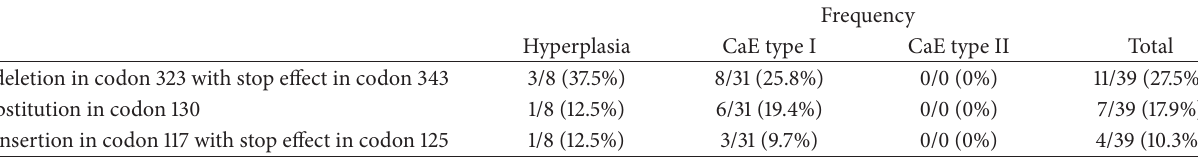
Table 3: The most frequent mutations in endometrial